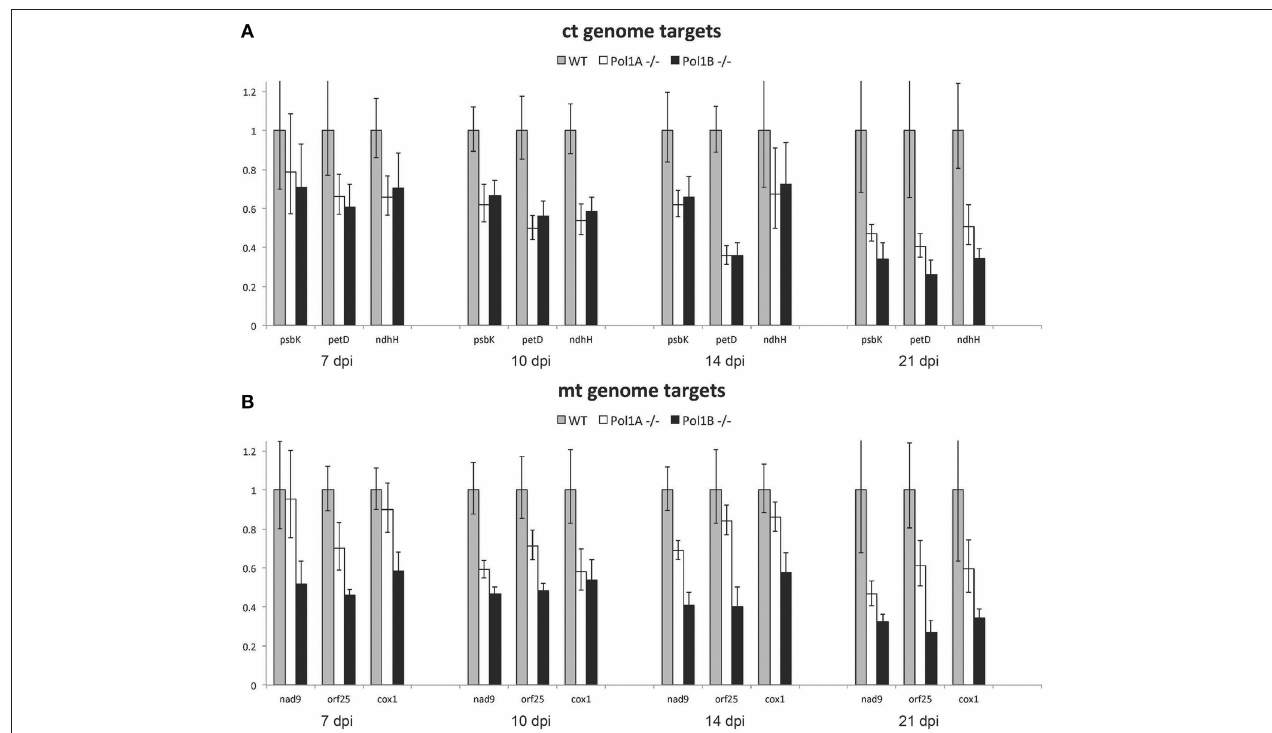
FIGURE 5 | Change in relative chloroplast and mitochondrial genome copy number. Note that mutations in Pol1A and Pol1B affect chloroplast genome copy number equally (A) however mutation of Pol1B causes a more severe drop in mitochondrial genome copy number (B) . In both mutants, genome copy number gradually decreases but remains lower than wild type as the plants age.